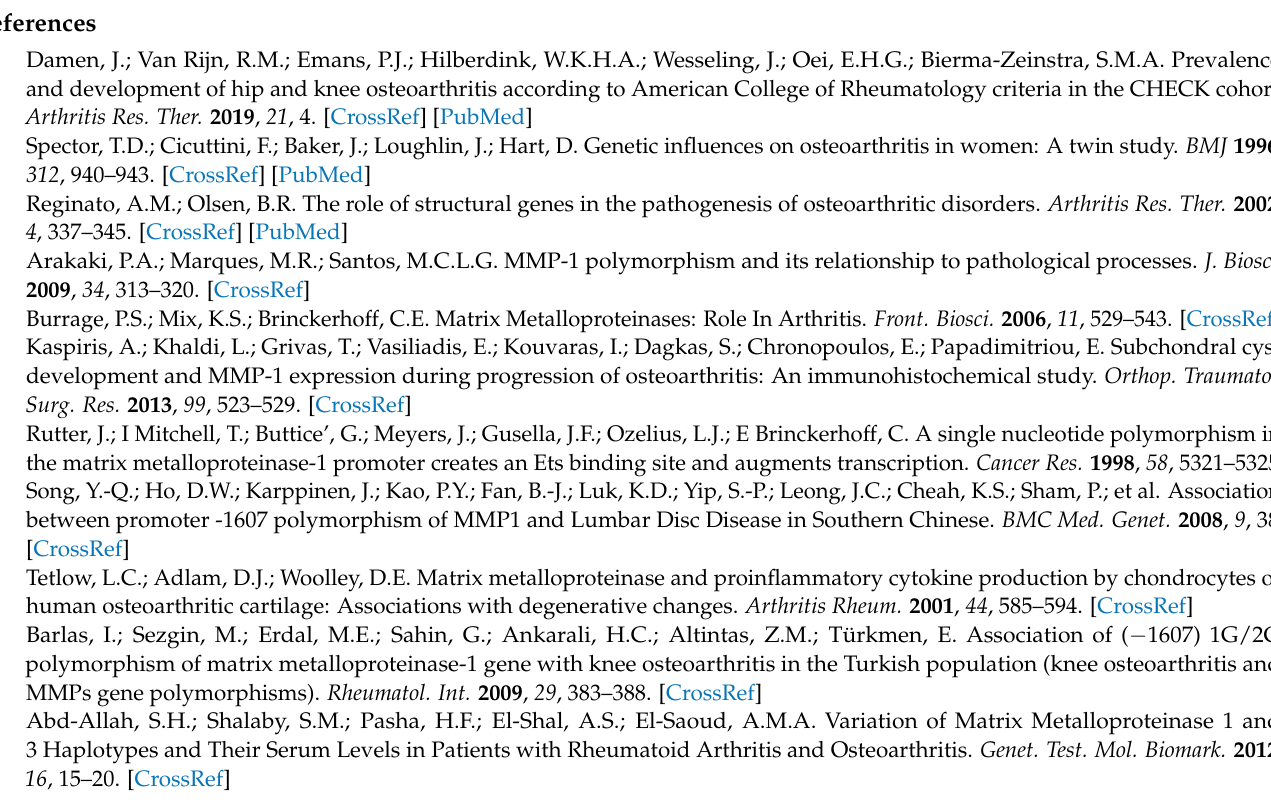
Supplementary Table S2. Search strategies and detailed records. Supplementary Table S3. Basic description of articles included in the meta-analysis. Supplementary Table S4. Quality evaluation of articles included in the meta-analysis. Supplementary Figure S1 Forest plot of the age-stratified